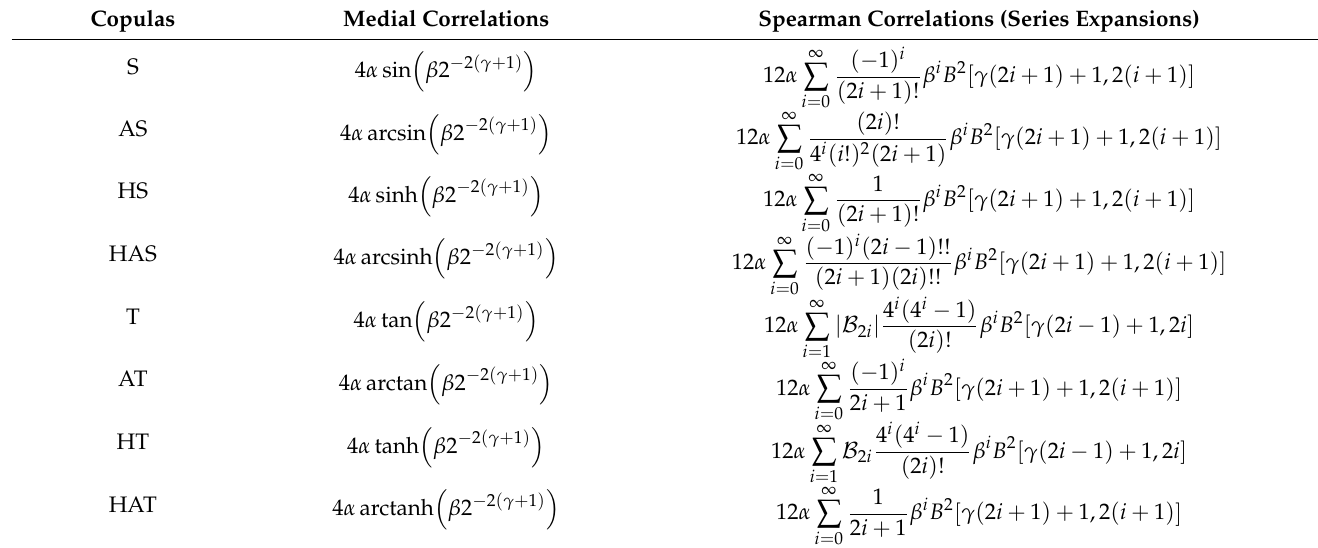
Table 1. Expressions of the medial correlations and series expansions of the Spearman correlations of the new copulas. Copulas Medial